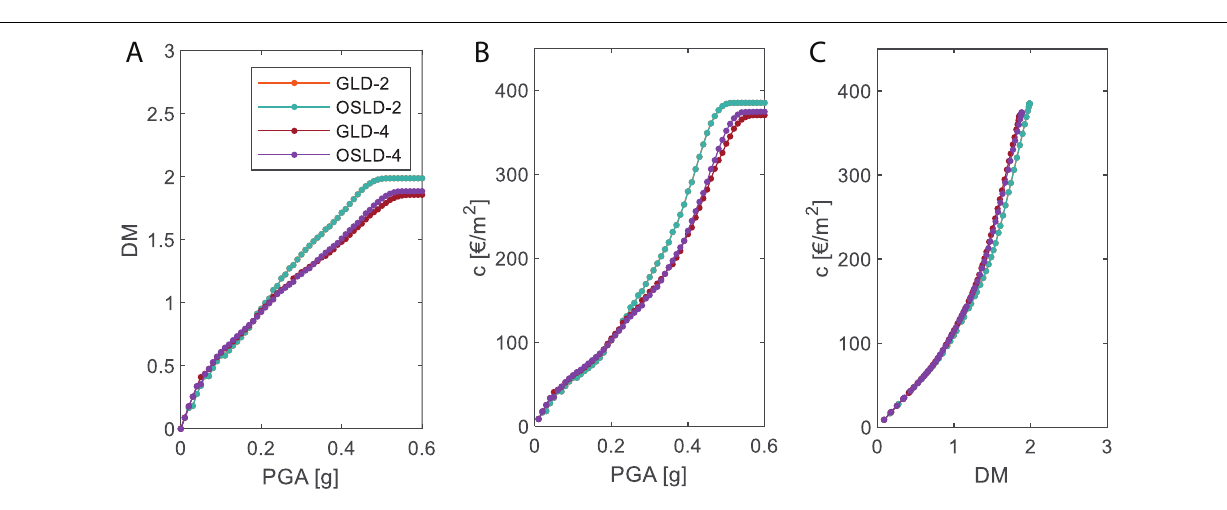
FIGURE 11 | Comparison among case study buildings: total mean damage (DM)-PGA (A) , total repair cost c per building area unit (B) , DM- c relationship (C) .